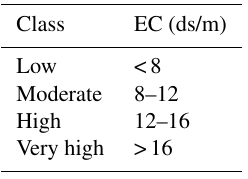
Table 2. Classification of soil EC values (Mokarram et al., 2010).